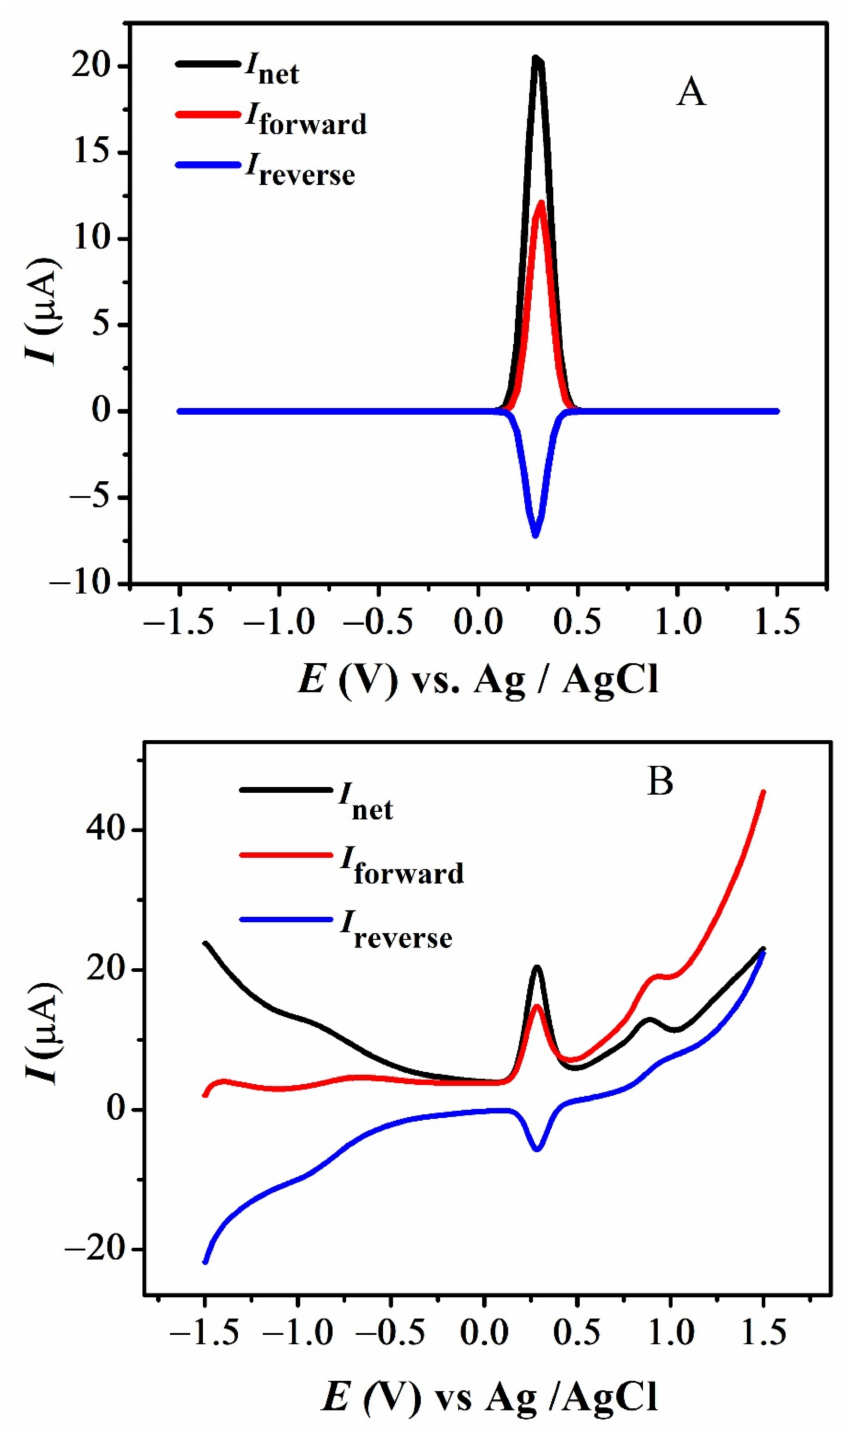
Figure 7. SWV indicating net, forward and reverse current for ( A ) FBA and ( B )